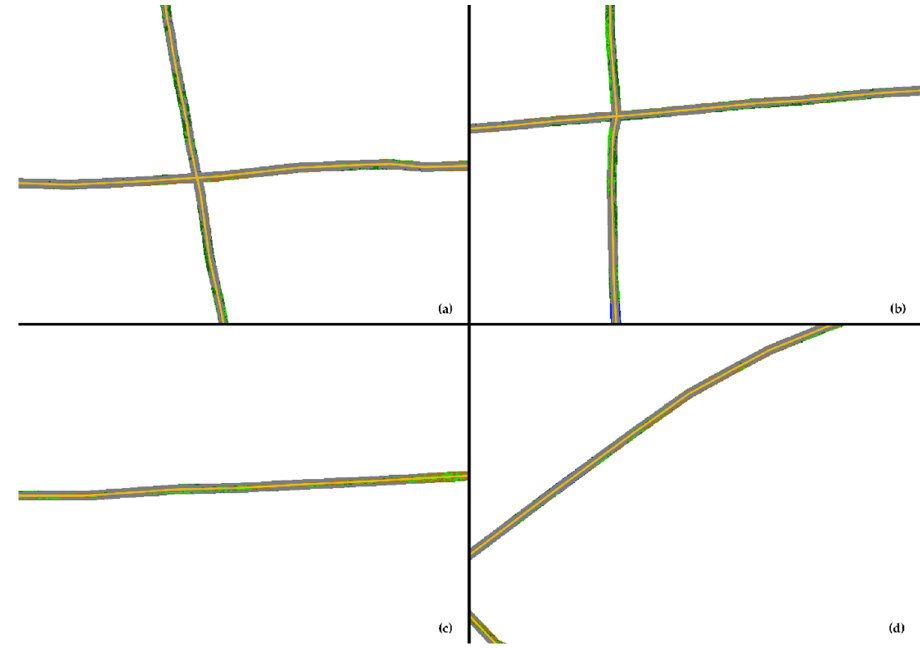
Figure 7. Highlighted results of clipped classification with 15 m buffer . Table 4. Potential planting areas (in square meters).